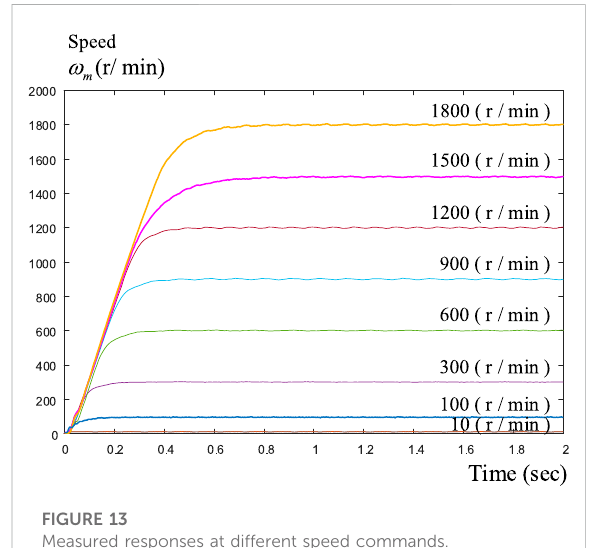
FIGURE 13 Measured responses at different speed